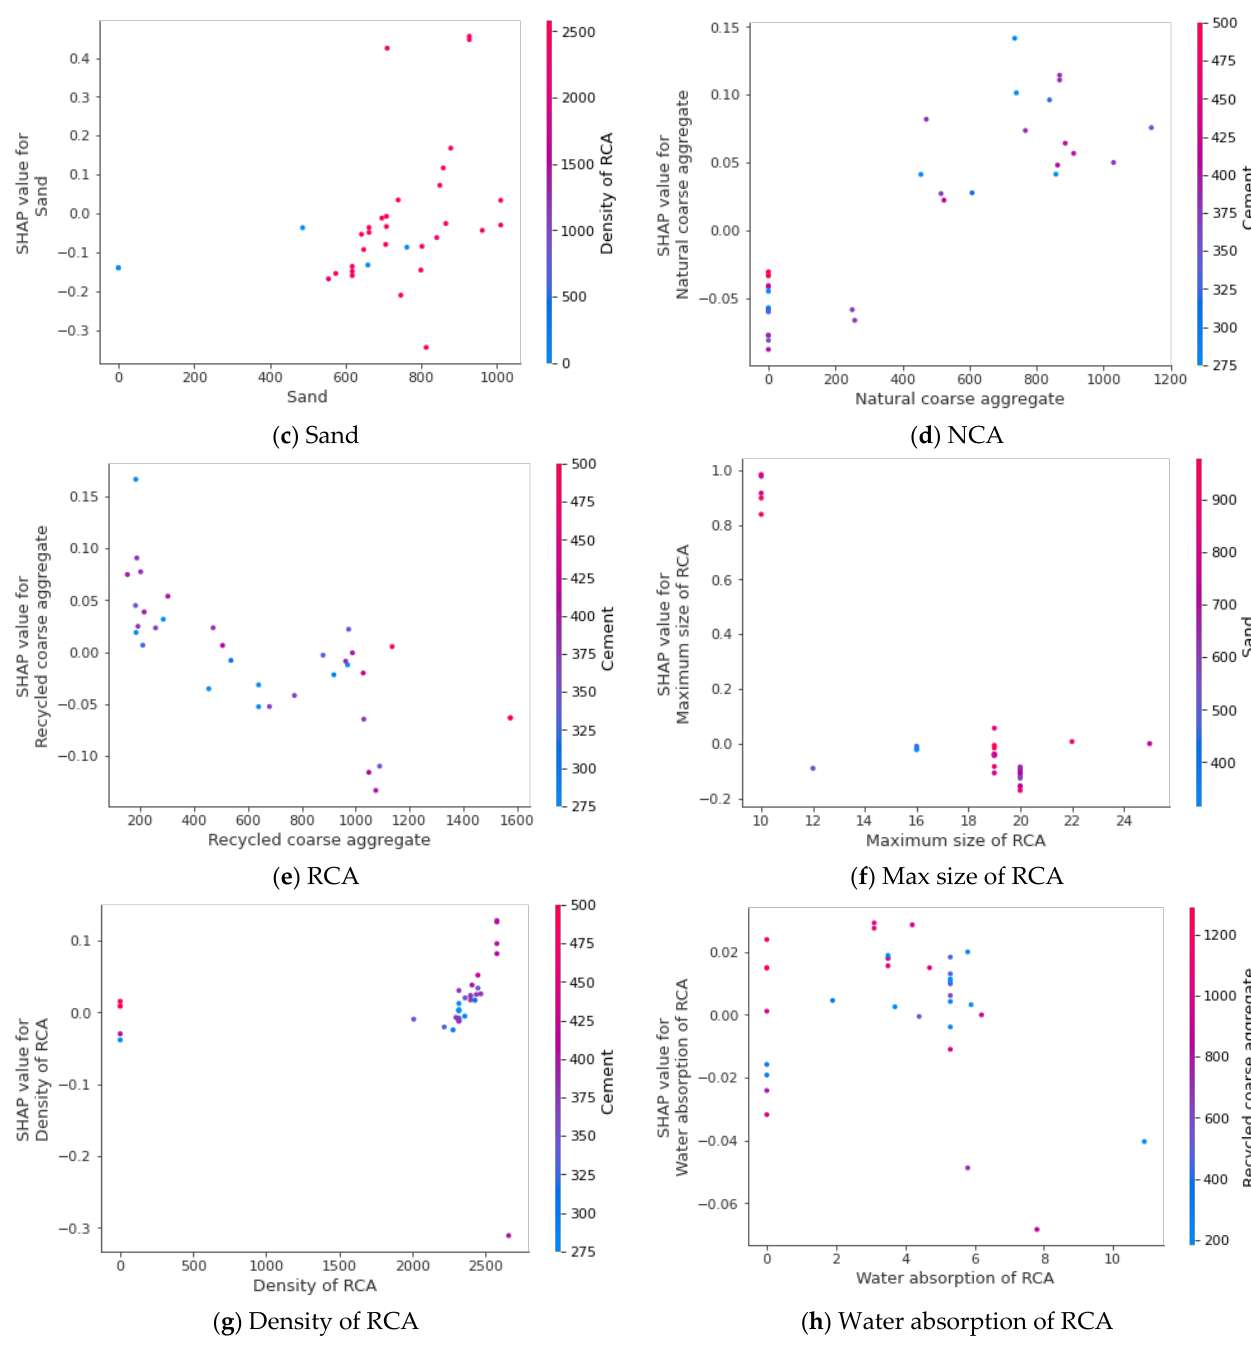
Figure 13. Effect of raw material on STS of recycled aggregate concrete.